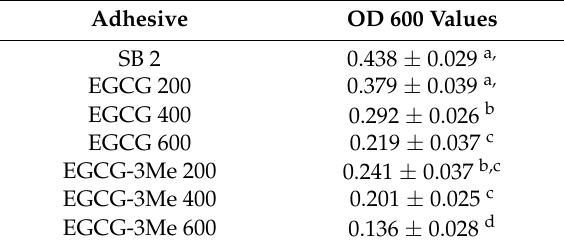
Table 2. The OD 600 values of the